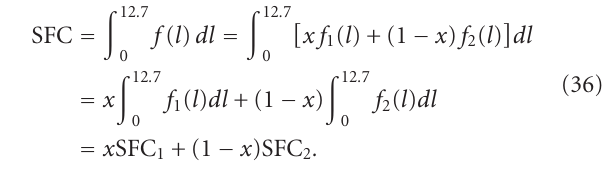
Figure 12: CV% dependence to x .